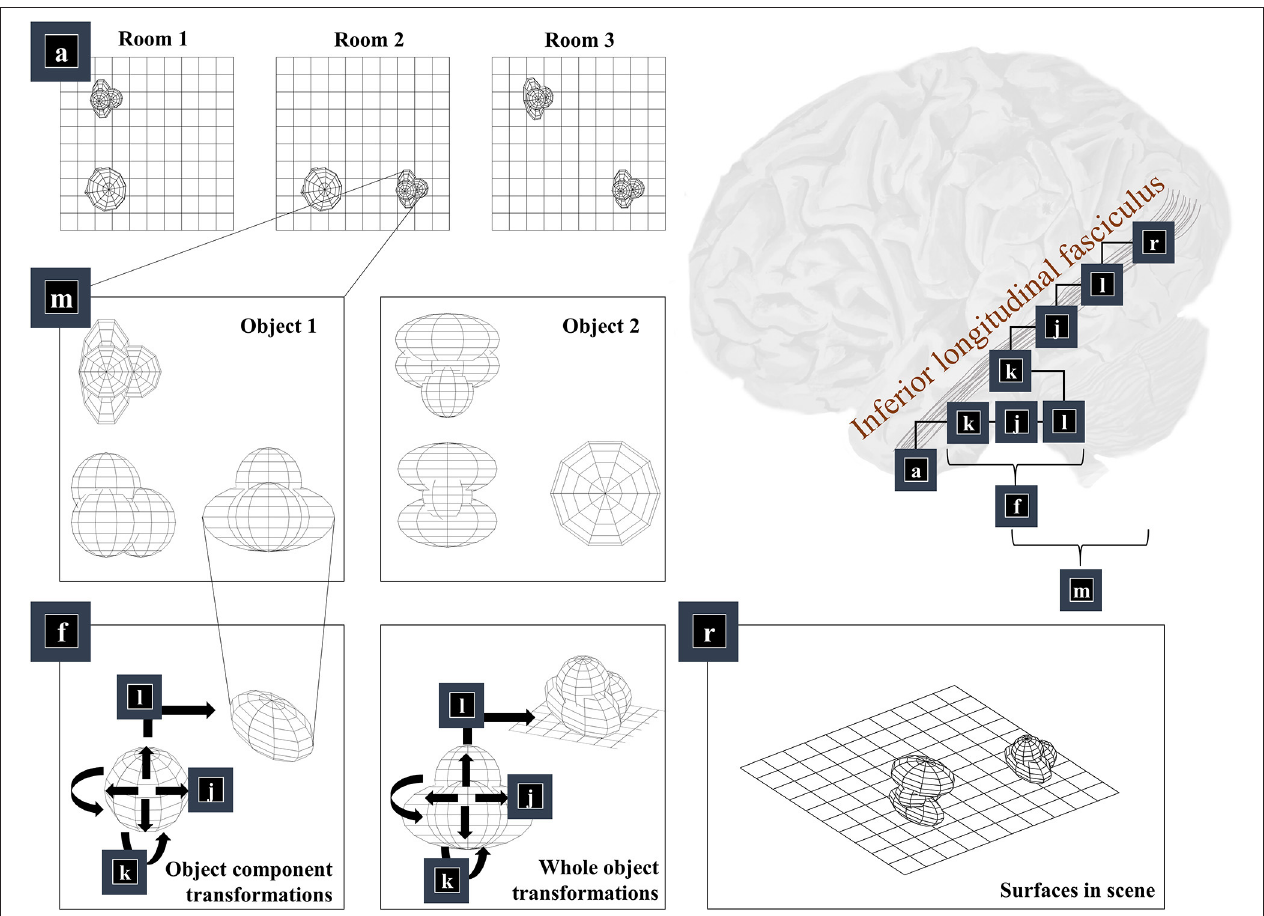
FIGURE 2 | The “what” pathway. This figure focuses upon part of the factor graph in Figure 1 . In the upper right, this factor graph is reproduced as it might be implemented neuroanatomically. Here, the factors are arranged along the occipitotemporal “what” pathway, which loosely follows those cortical areas superficial to a white matter tract called the inferior longitudinal fasciculus. The panels on the left show the sequence of steps implemented by these factors. Factor a is the distribution over alternative rooms (or scenes) we could find ourselves in. This implies a categorical distribution assigning a probability to each of the rooms provided in the example graphics. Conditioned upon being in a room, we may be able to predict which objects are present. Two example objects are shown (from three orthogonal views). The conditional probability distribution for the geometry of the objects given the room is given by the m factor, which is here broken down into several constituent factors. First, we need to know the identity of the objects in the room ( f ), which we operationalise in terms of the configuration of the parts of that object. Specifically, we decompose f into a series of transformations ( k - l ) applied to a set of spheres, which represent the constituents of the object. In principle, we could have used other objects in place of spheres, or could have applied this procedure recursively, such that the constituents of an object can themselves be decomposed into their constituents. Once we have our object, we can apply the same transformations ( k-l ) to the whole to position it our room. We do this for each object in the room, eventually coming to a representation of all the surfaces in the scene ( r ), shown in the lower right